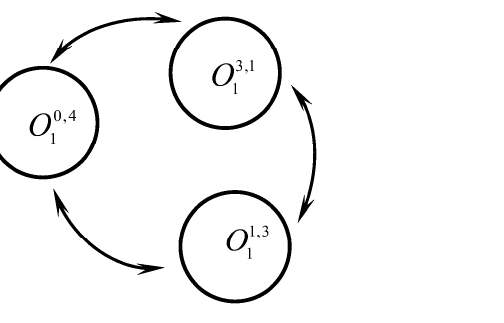
Figure 1. Possible types (cases) and transitions for the first ( O 1 ) and the second ( O 2 ) equilibria of system (2) depending on the roots of the characteristic Equation (29), when b 1 ∈ [ 0.01, 1.5 ] , b 2 ∈ [ − 2, − 0.01 ] , b 3 ∈ [ 0.01, 2.5 ] , b 4 ∈ [ 0.01, 0.7 ] and all another parameter values are as those in the original Rössler hyperchaotic system, see in [11]. The dotted line remarks that transition between O 3,1 and O 1,3 can be seen only in a small number of values for b 1 − b 4 and that is why it is not